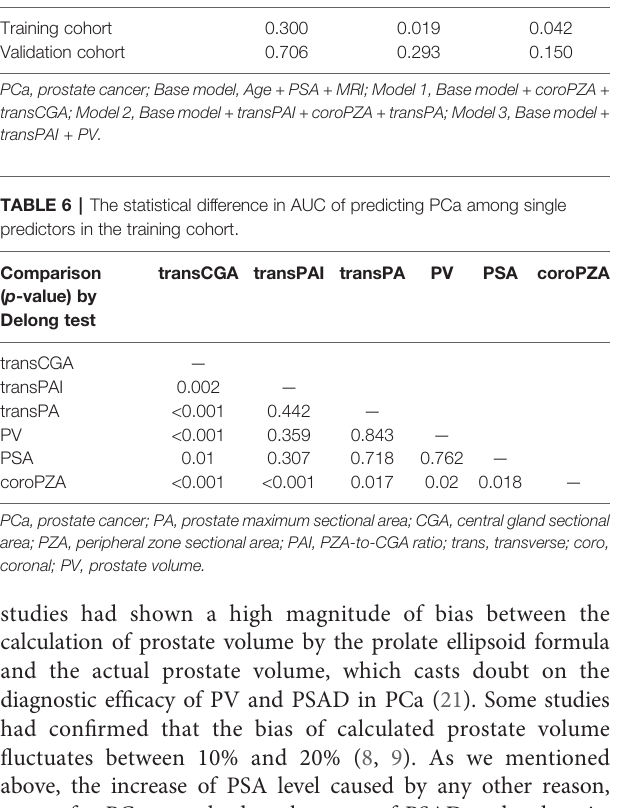
TABLE 5 | The statistical difference in AUC of predicting PCa among three models. Comparison ( p -value)by Delong test